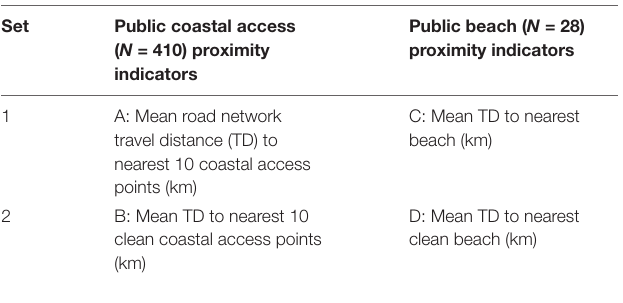
TABLE 1 | Proximity